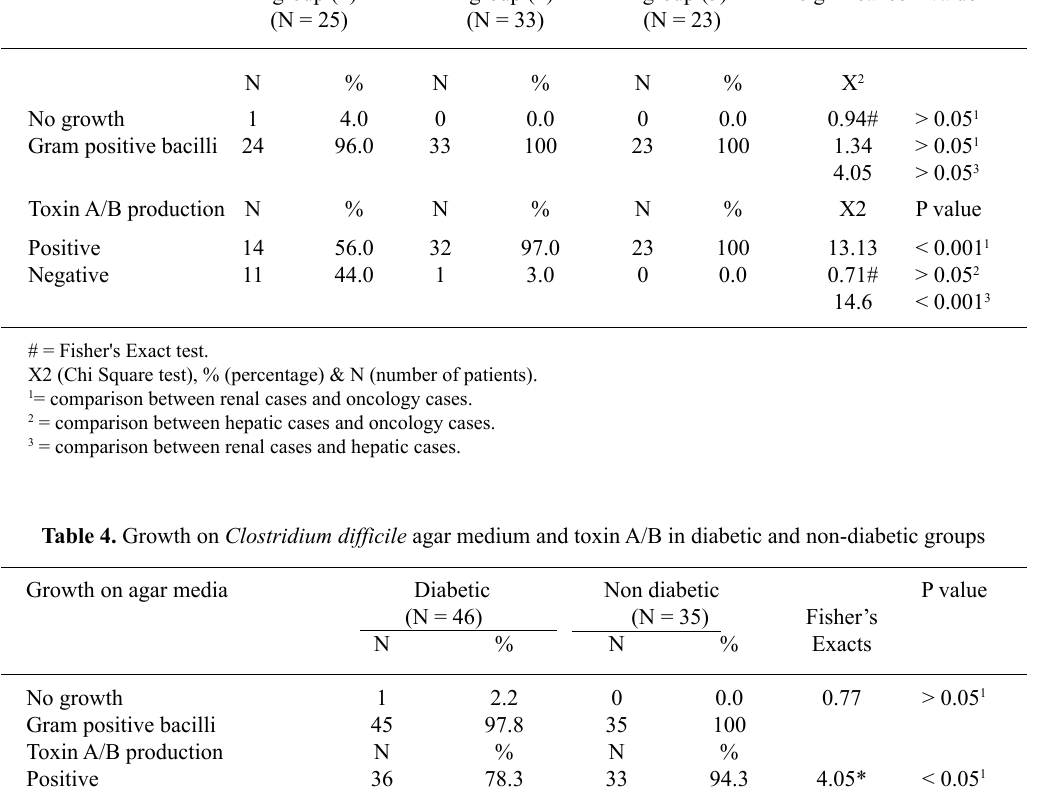
table 3. Growth on Clostridium difficile agar medium and toxin A/B production Growth on agar media